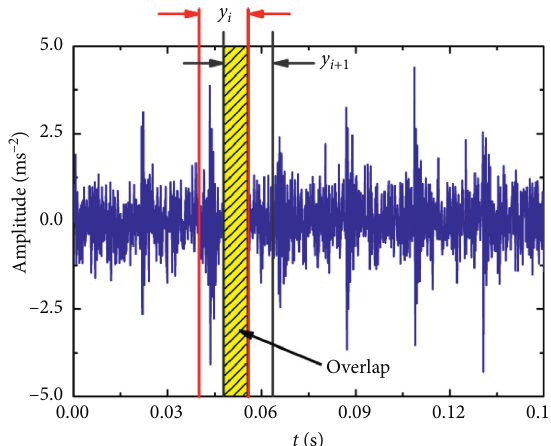
Figure 1: The signal is segmented into a series of truncated-signals with a certain